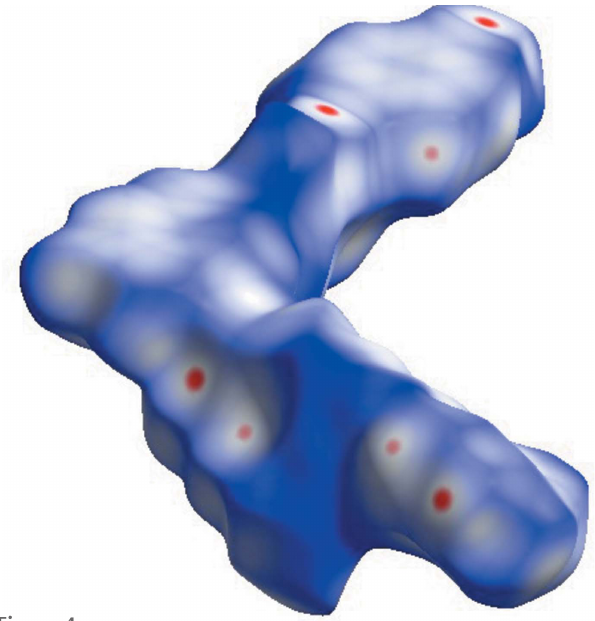
Figure 4 Hirshfeld surface of the title compound mapped with d norm .